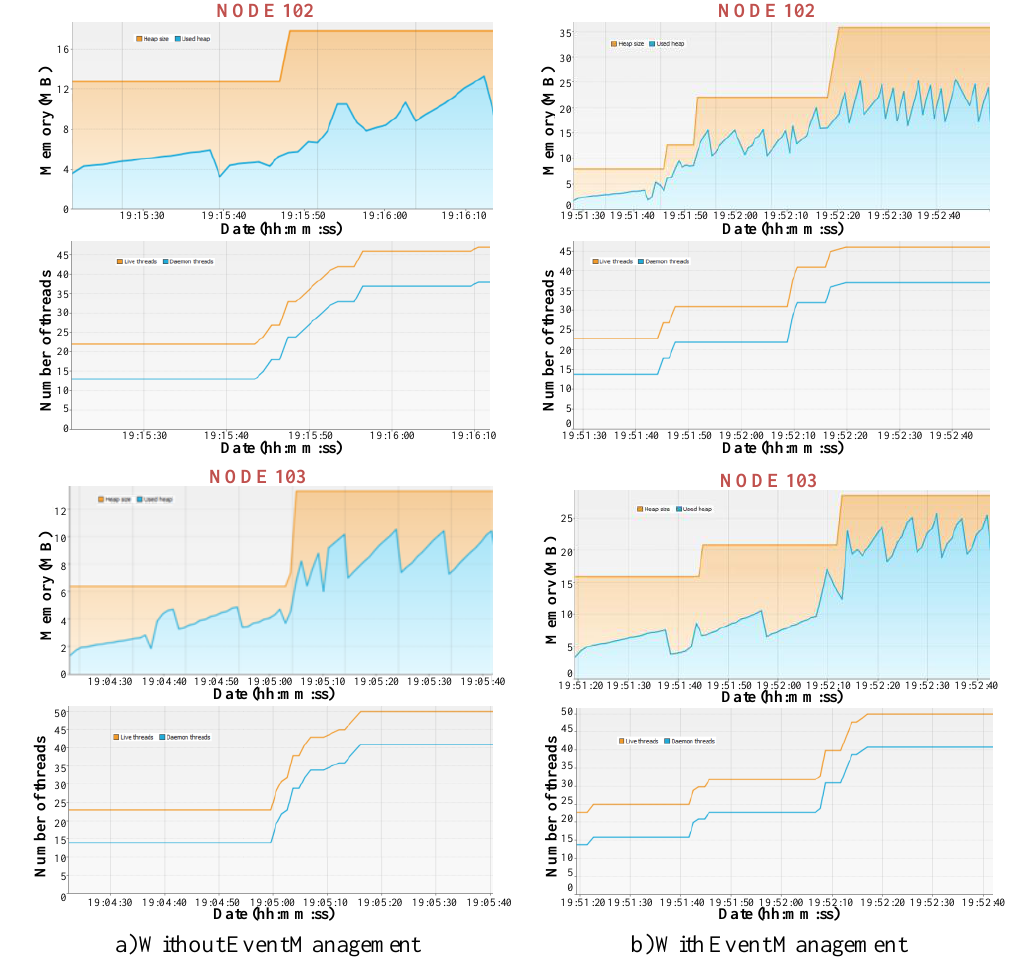
Figure 15. Resource usage in terms of memory usage. ( a ) without event management; ( b ) with event management.